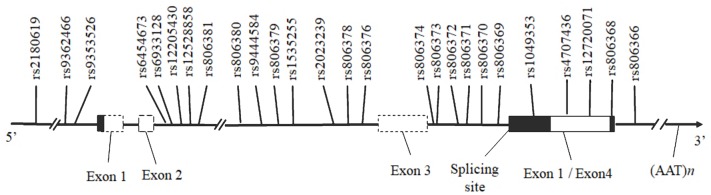
Schematic diagram of the human CNR1 and the positions of the SNPs investigated. Horizontal black arrows indicate the direction of transcription. The white bar represents the exonic region according to the National Center for Biotechnology Information (NCBI) and the University of California at Santa Cruz Browser (UCSC). The gray region within the white bar corresponds to the alternative splicing coding region, and the untranslated region is shown in black.